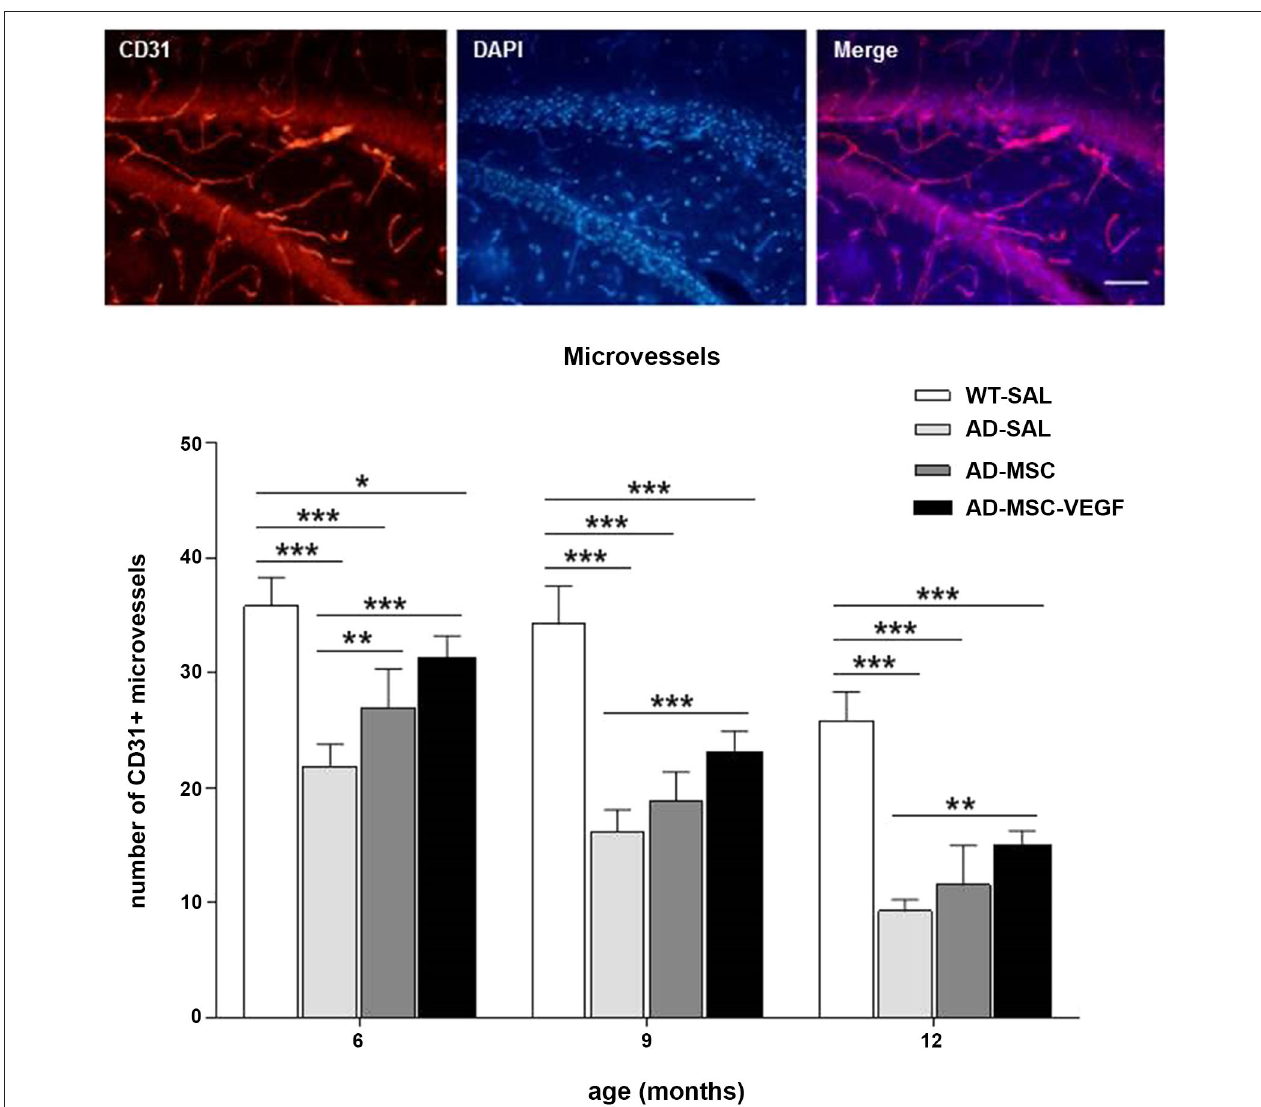
the hippocampus at the ages of 6, 9 and 12 months in the WT-SAL, AD-SAL, AD-MSC and AD-MSC-VEGF animals (two-way ANOVA followed by Tukey’s multiple comparisons test, mean ± standard error; * P < 0.05; ** P < 0.01; *** P < 0.001, n = 5 per